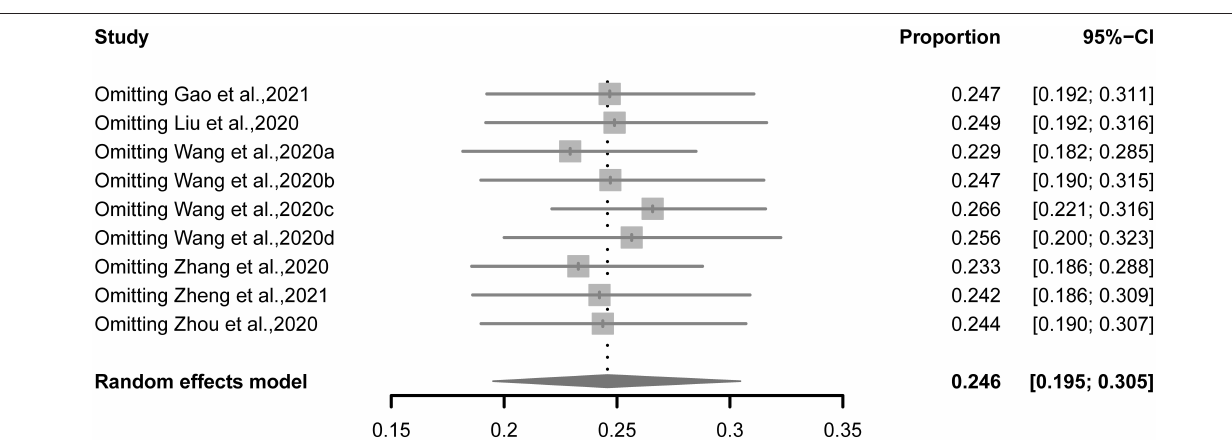
Frontiers in Medicine |